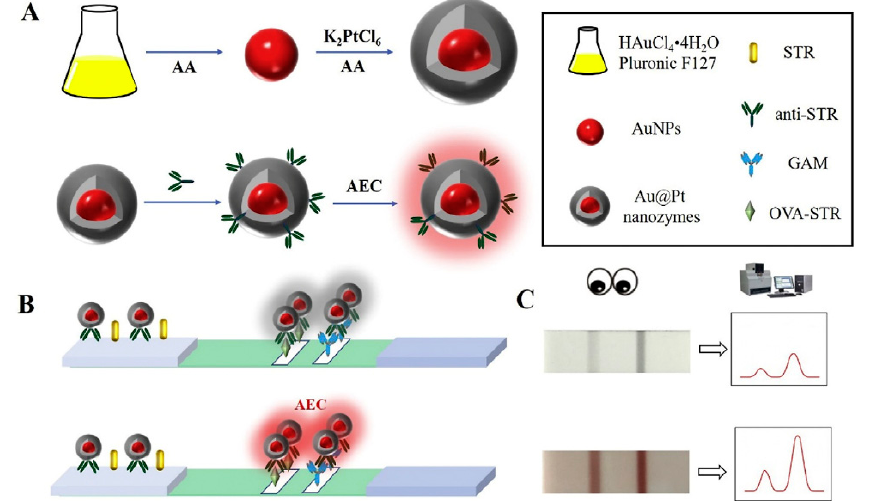
Figure 5 . Schematic illustration for the colorimetric LFA based on Au-Pt: ( A ) preparation of Au@Pt nanozyme; ( B ) process of the colorimetric LFA based on Au-Pt; ( C ) typical results of the colorimetric LFA assay based on Au-Pt. Reprinted from Ref [97], Copyright (2020), with permission from Elsevier.